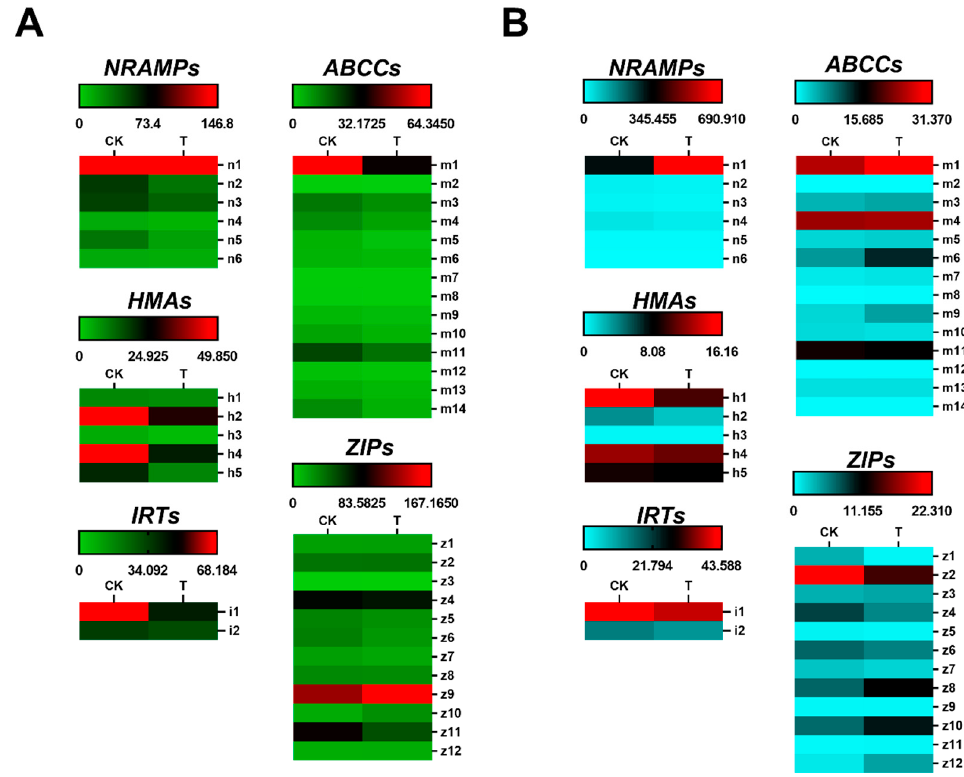
Figure 4. Heat map of main cadmium transporter genes in different treatments of Cd-N roots and shoots. ( A ) NRAMP, HMA, ABCC, and ZIP gene family expression in Cd-N roots. ( B ) NRAMP, HMA, ABCC, and ZIP gene family expression in Cd-N shoots. (CK is the control group with 1 mM phosphate and 8.896 µ M cadmium, T is treatment group with 3 mM phosphate and 8.896 µ M cadmium; n = 3).